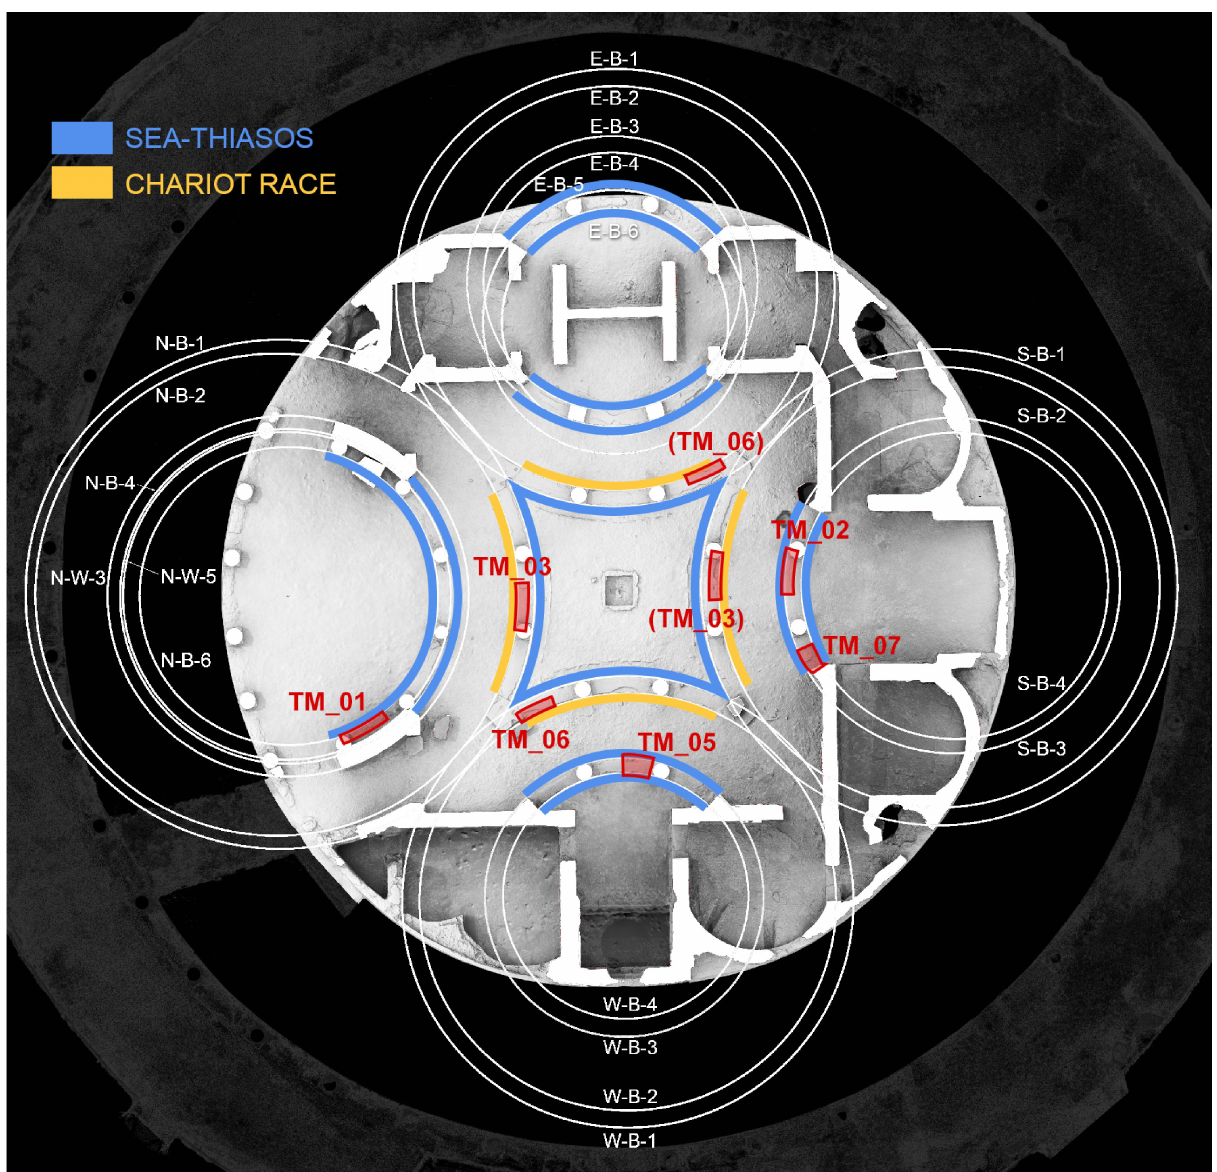
Figure 12. Plan with the friezes in his supposed original position